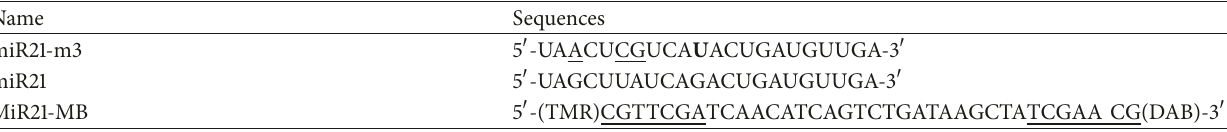
Table 1: Oligonucleotide strands with